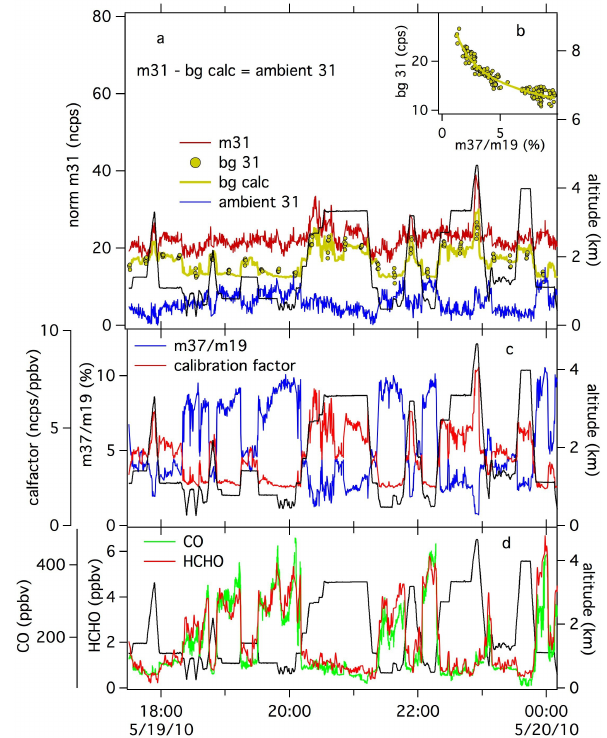
Fig. 7. Example flight on 19 May 2010 during CalNex 2010. (a) Raw signals (ambient and instrument backgrounds) of HCHO during the flight. (b) Humidity dependence of the instrument background signal. (c) Calibration factor estimated from the mass37/mass19 ratio. (d) HCHO mixing ratio together with